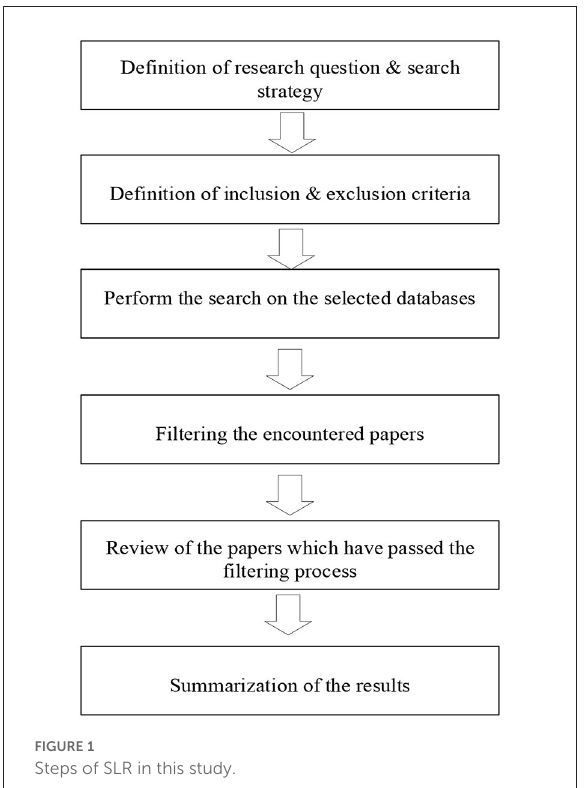
FIGURE1 Steps of SLR in this